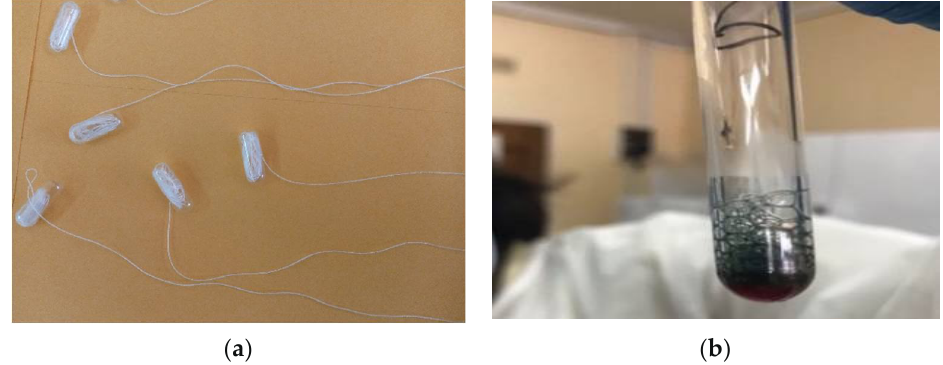
Figure 1. Panel ( a ) Images of the S-filum; ( b ) an example of the blue colour change occurring on mixing dissolved guaiacum powered, hydrogen peroxide and a solution containing blood.